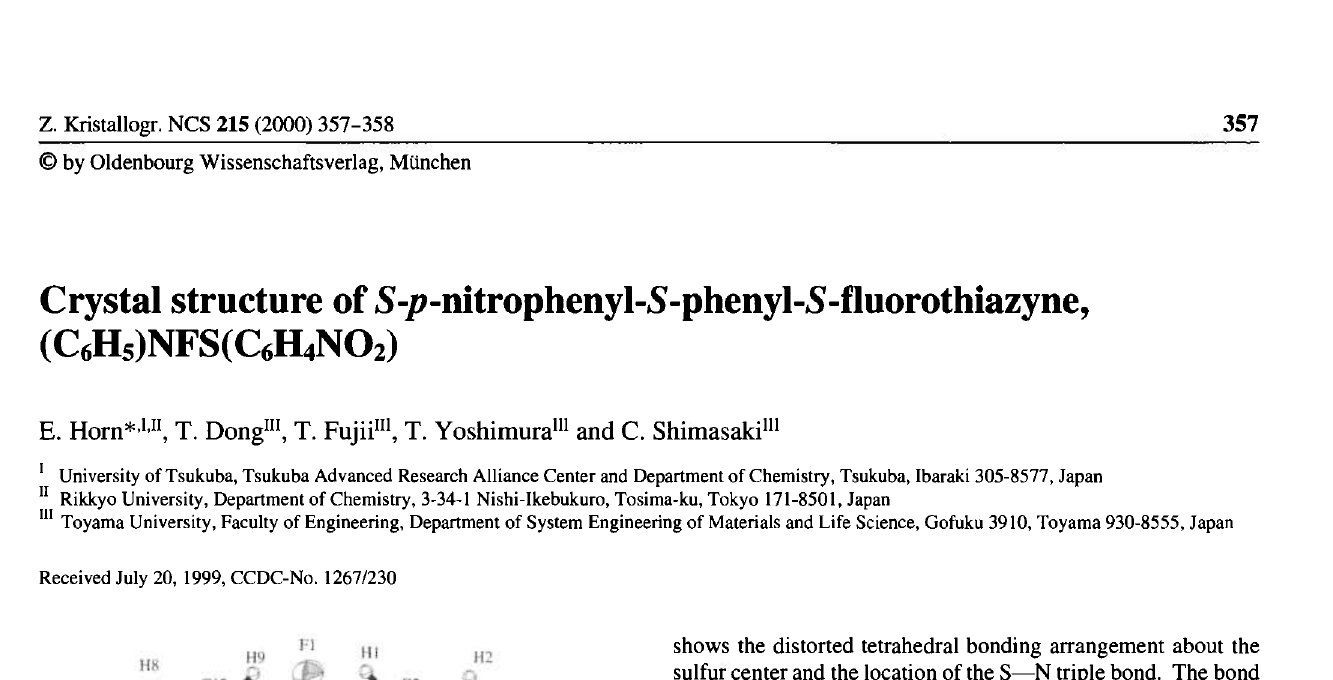
Table 1. Data collection and handling.